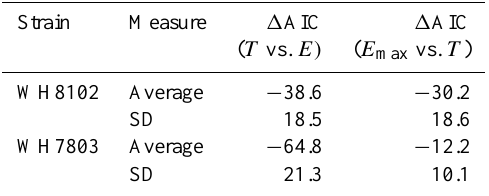
Table 3. Difference in AICs calculated for E , T and E max model fits to experimental data on the response of Synechococcus photo- synthesis to UV+PAR exposure. The comparison is limited to ex- periments conducted after a 1h pre-exposure of culture sample to moderate UV+PAR (see Sect. 2).